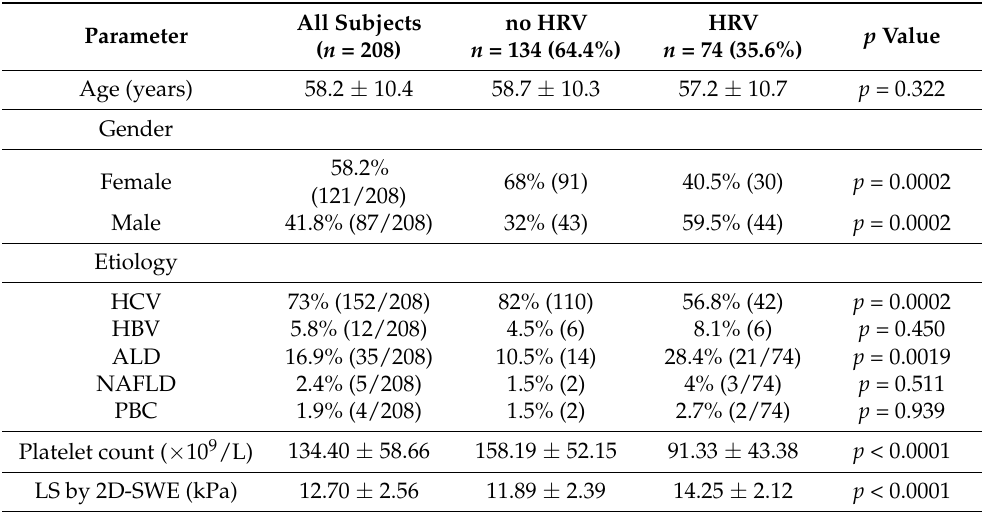
Table 1. Main characteristics of the included